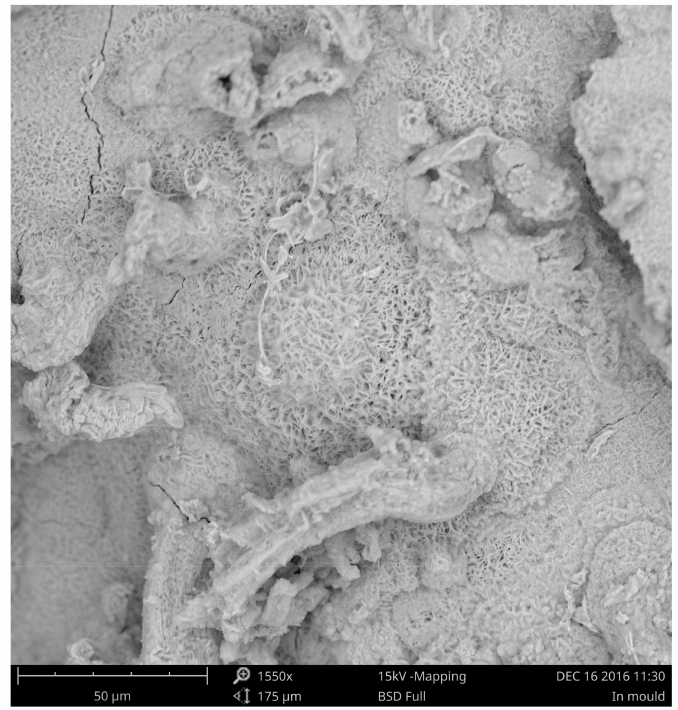
Figure 7. Corrosion products on the surface of the ductile iron casting done using the in-mold method.